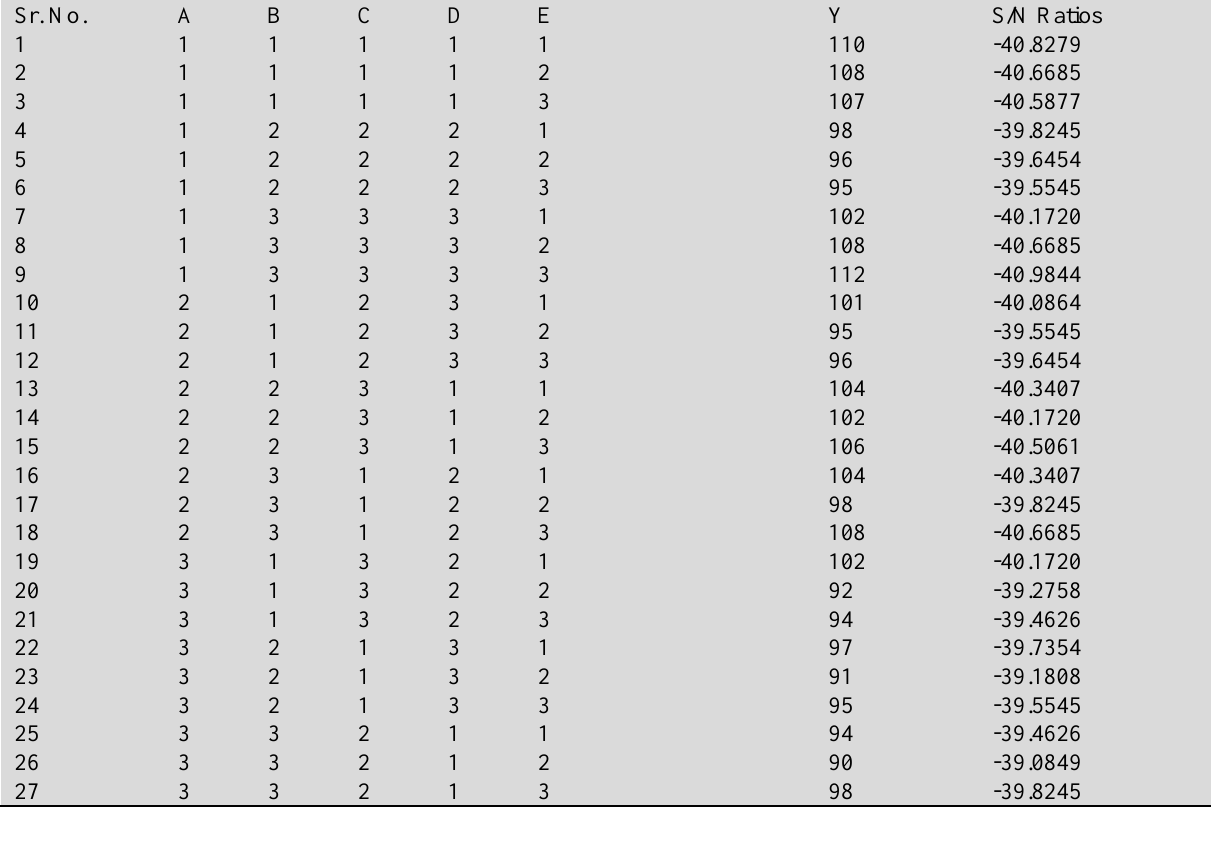
L 27 Orthogonal array for experiments with responses and S/N ratios Sr. No.